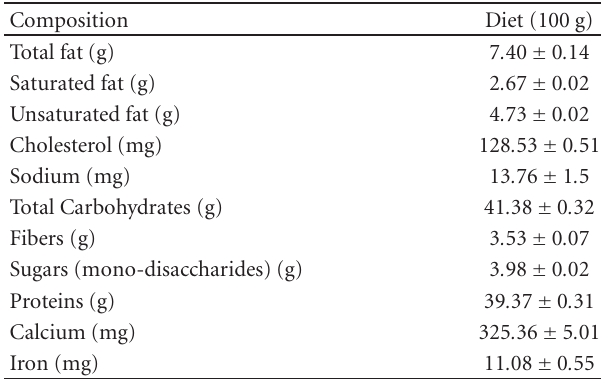
Table 1: Proximal composition of the experimental diet (dry matter). Values are expressed as mean ± SEM. Analysis were carried out in duplicate on 4 di ff erent batches ( n =